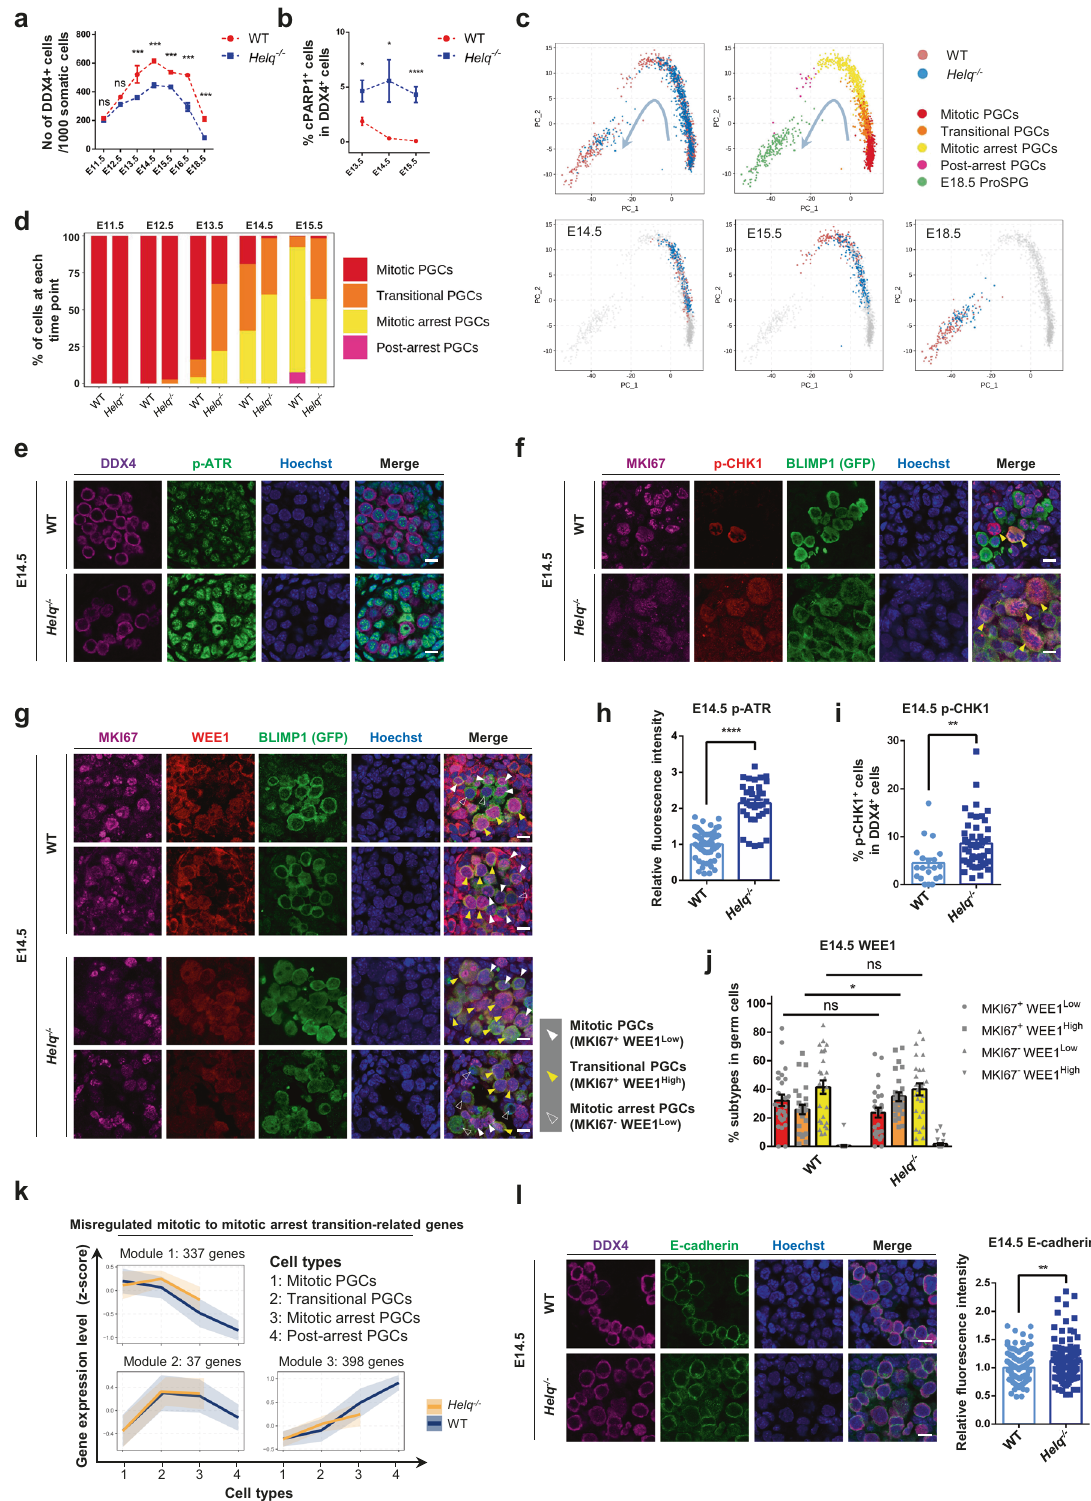
PGCs, respectively (Supplementary Fig. 9a, Supplementary associated with male germ cell development such as “ Cilium Data 3). As expected, genes involved in cell-cycle checkpoint- organization ” and “ Flagellated sperm motility ” (Supplementary related processes were upregulated in Helq − / − PGCs (Supple- Fig. 9b, Supplementary Data 3). In accordance with the abnormal mentary Data 3), con fi rming that HELQ might act on cell-cycle developmental trajectory of PGCs in Helq − / − mice, we found that the expression dynamics of the three categories of genes, which checkpoint through maintaining DNA integrity during the were necessary for the proper cell-fate transition from mitotic to mitotic arrest process in male PGCs. In contrast, the genes post-arrest PGCs, were dysregulated (Fig. 5k). Among them, downregulated in Helq − / − mitotic arrest germ cells were mostly NATURE COMMUNICATIONS| (2021) 12:6839